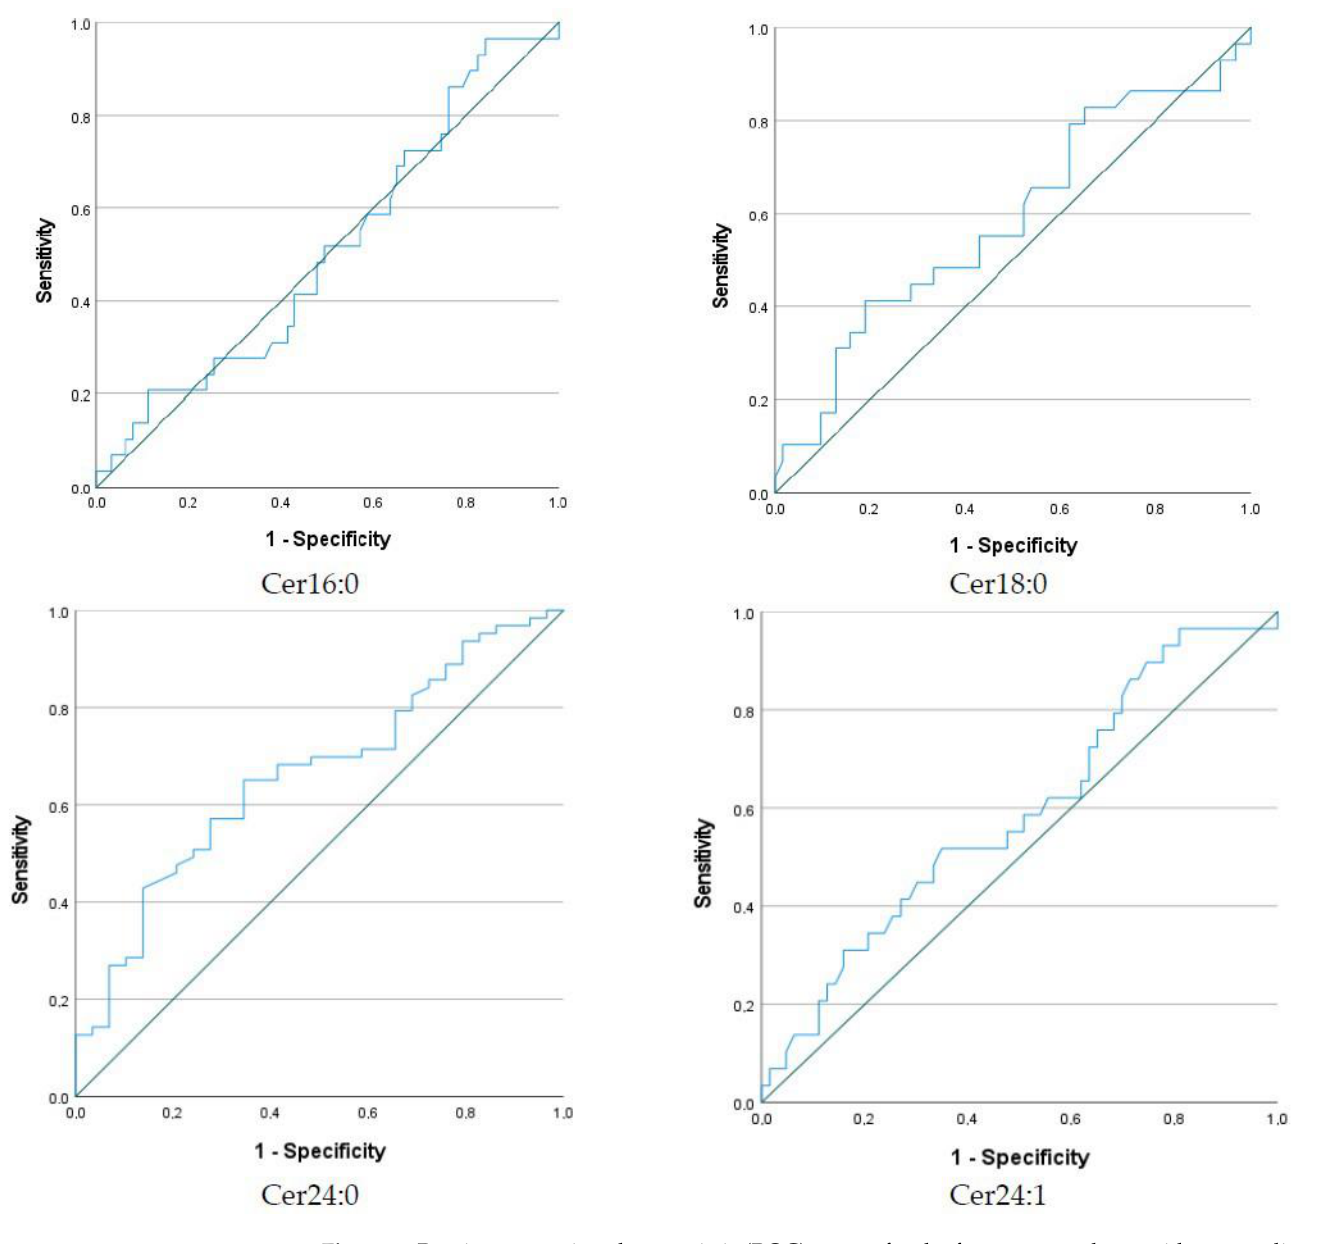
Figure 2. Receiver operating characteristic (ROC) curves for the four measured ceramides to predict GDM status.